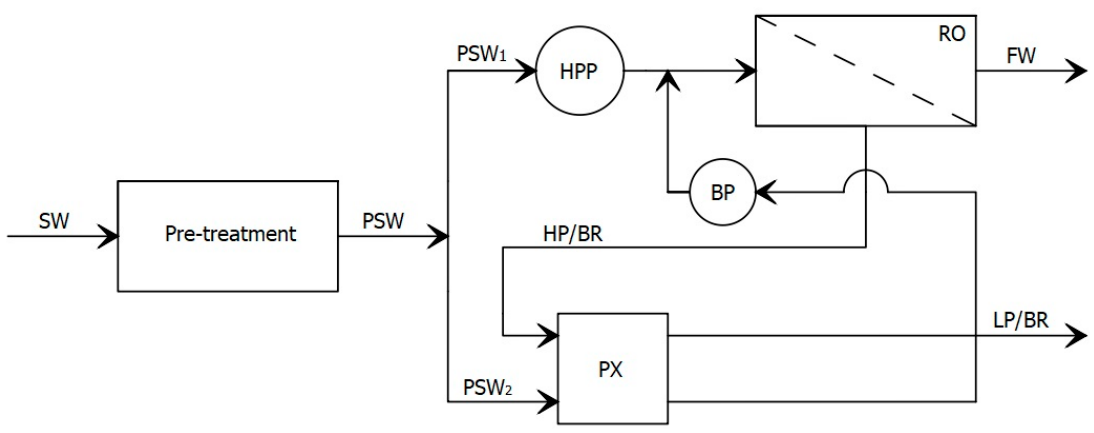
Figure 4. Schematic diagram of a typical modern RO seawater desalination process ISWRO with energy recovery from the brine.